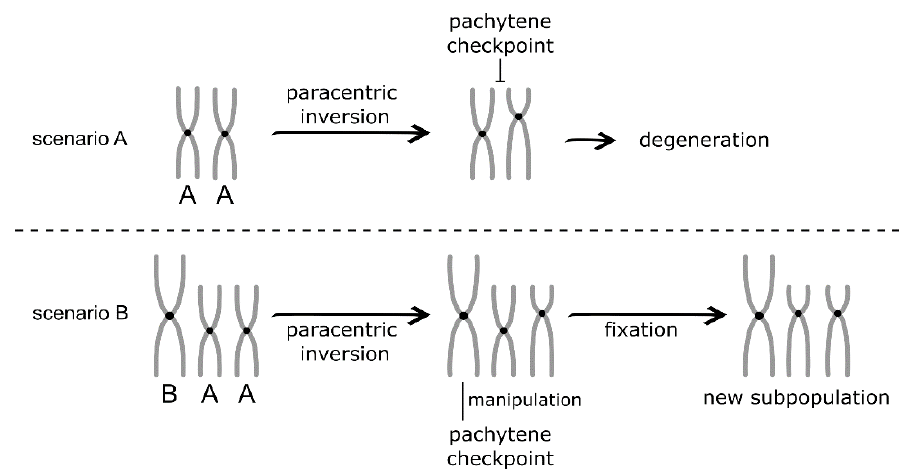
Figure 4. Pachytene checkpoint speciation model facilitated by regulatory networks impacted by the B chromosome. In scenario A, the pachytene checkpoint blocks the fixation of rearranged chromosomes. In scenario B, the manipulation of pachytene checkpoint by the B chromosome for its own correct segregation allows rearranged chromosome to be fixed in a new subpopulation.